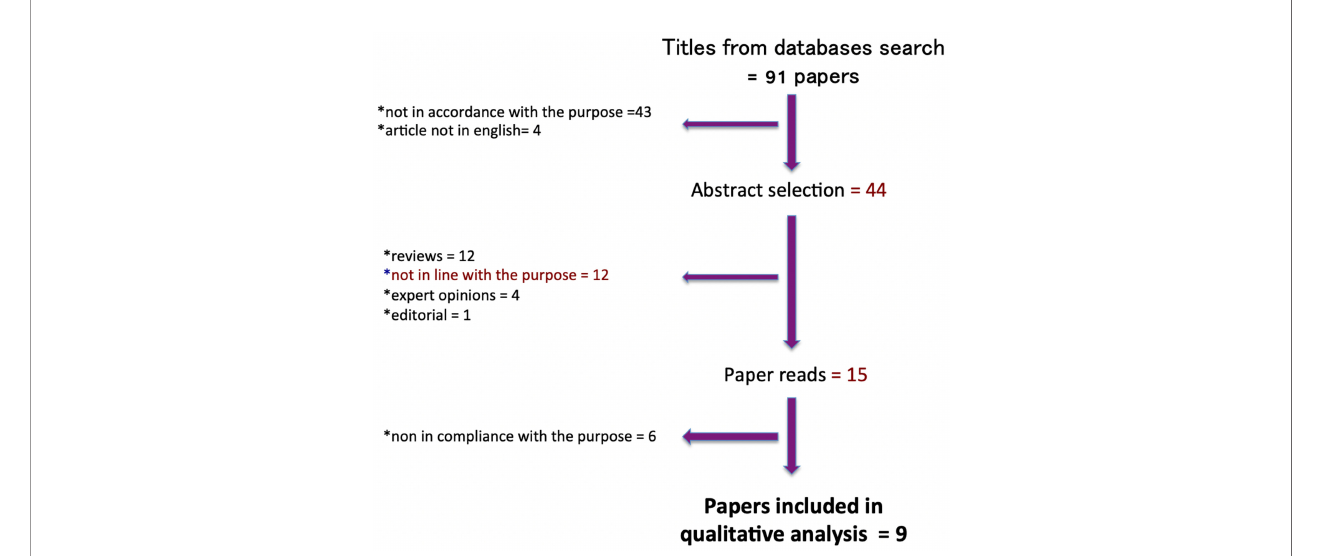
FIGURE 1 | Prisma diagram detailing the literature search process and article